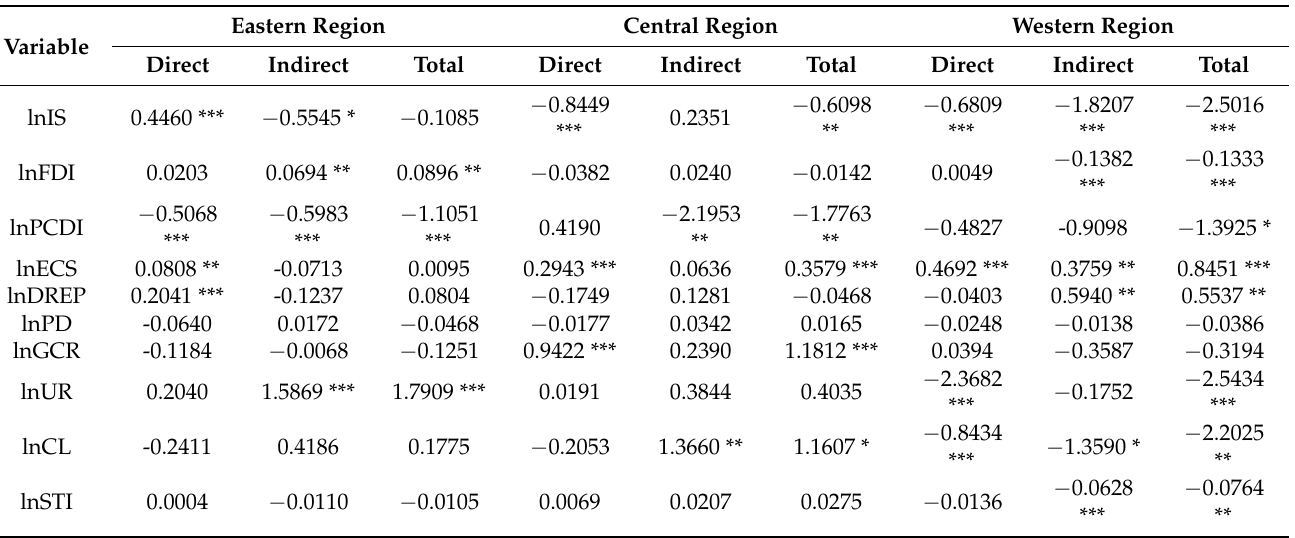
Table 13. Decomposition of sample effects of carbon emission intensity of urban production and energy consumption by region.